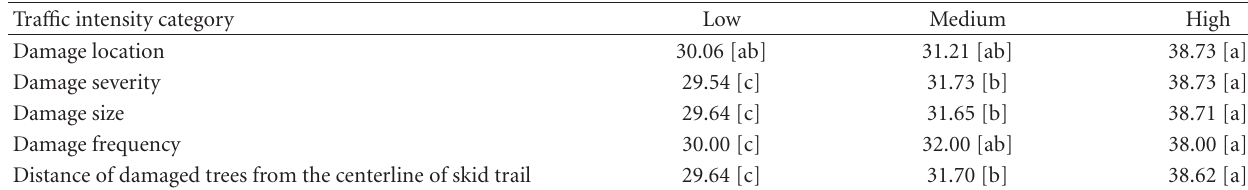
Table 10: All categories of damage by tra ffi c intensity